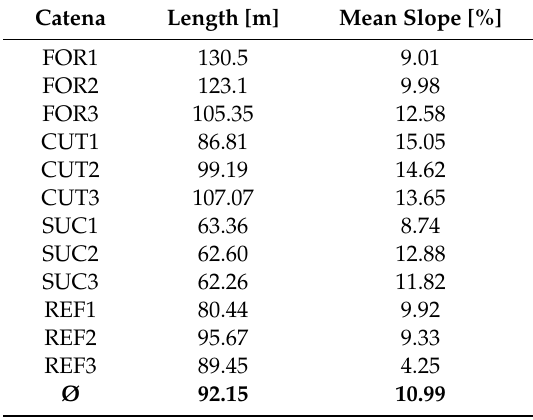
Table 2. Slope parameters for every catena; (FOR)est, (CUT)-down, (SUC)cession, (REF)forested.